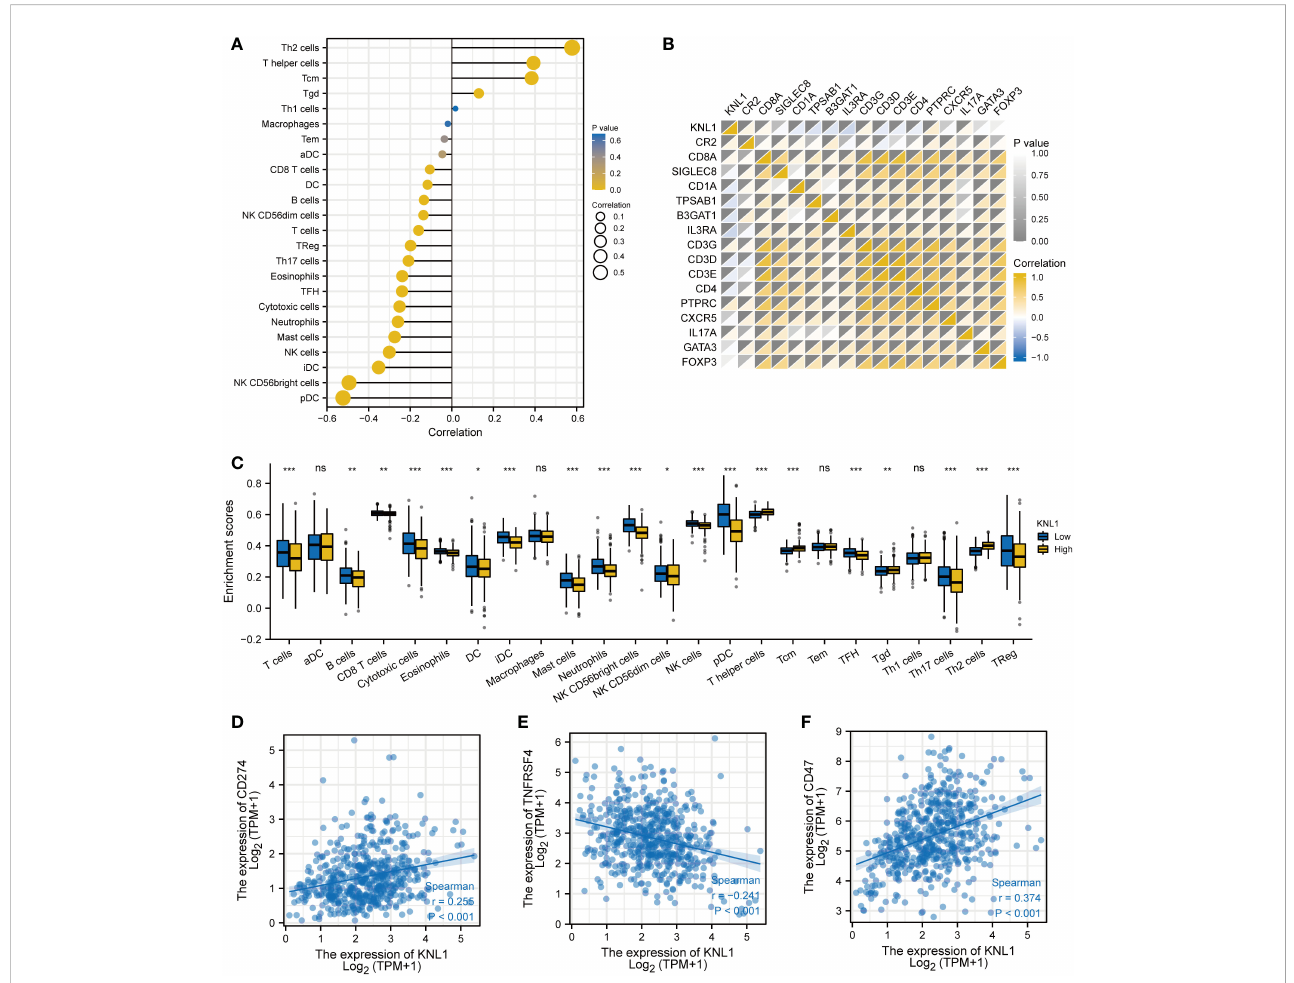
FIGURE 5 Immunoin fi ltration analysis of KNL1. (A) Correlation analysis between KNL1 and 24 immune cell in fi ltration levels. (B) Heatmap of the correlation between KNL1 expression and various immune cell surface marker proteins: CR2 (B cells), CD8A (cytotoxic cells), SIGLEC8 (eosinophils), CD1A (iDCs), TPSAB1 (mast cells), B3GAT1 (NK cells), IL3RA (pDCs), CD3G (T cells), CD3D (T cells), CD3E (T cells), CD4 (T helper cells), PTPRC (Tcm), CXCR5 (Tfh), IL17A (Th17), GATA3 (Th2), and FOXP3 (Treg). (C) In fi ltration levels of 24 kinds of immune cells in samples with different KNL1 expression levels. (D – F) Correlation analysis between KNL1 and the expression levels of CD274, TNFRSF4 and CD47. Signi fi cance identi fi er: ns (no signi fi cance), p ≥ 0.05; *, p< 0.05; **, p<0.01; ***,